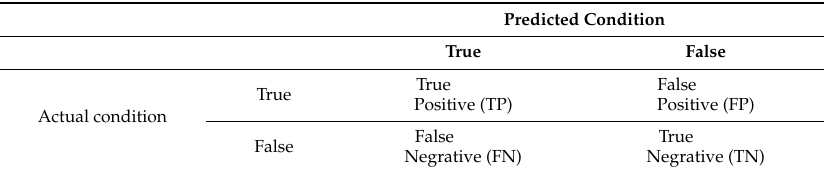
Table 2. An example of a confusion